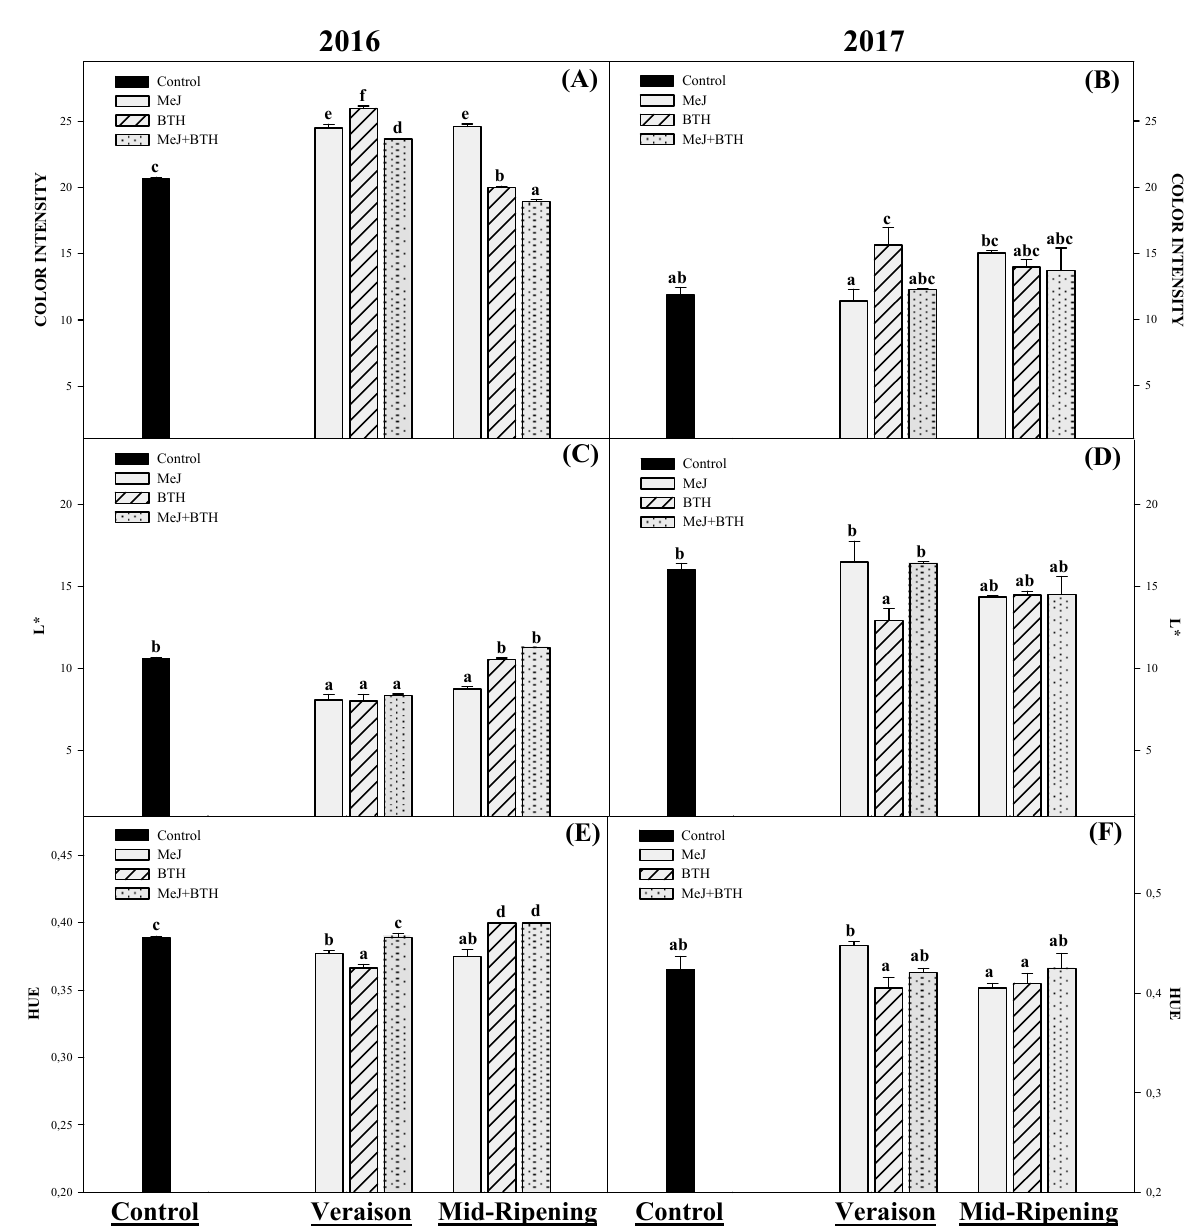
Figure 3. Color intensity, L* and hue in Monastrell wines made from grapes treated with MeJ, BTH, or MeJ + BTH at two different times: veraison and mid-ripening. Different letters indicate significant differences according to Duncan’s test ( p < 0.05).